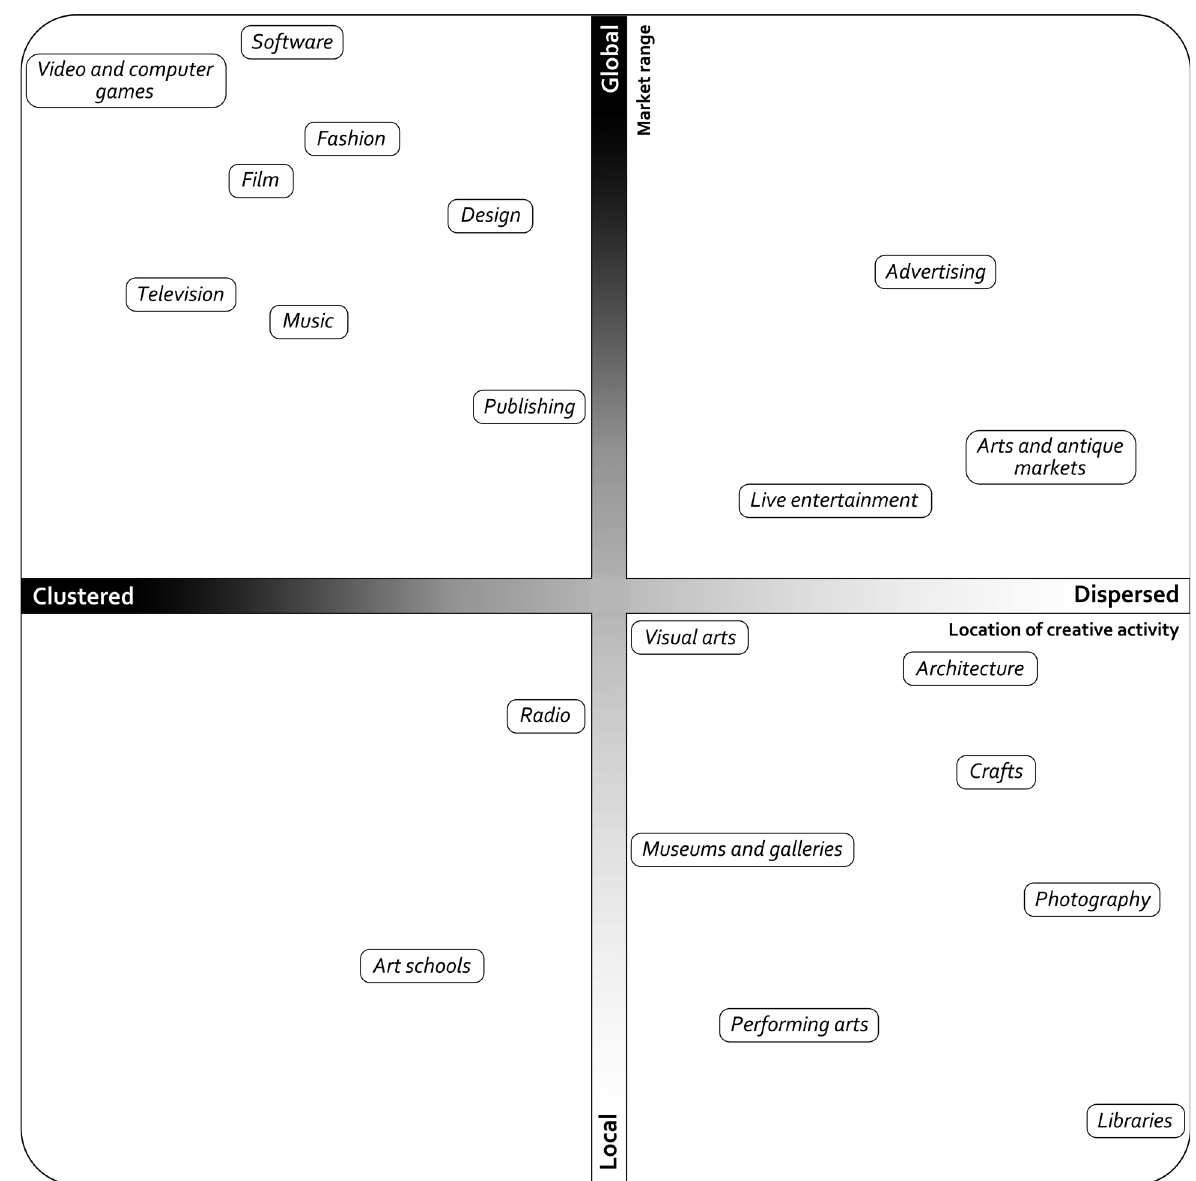
fig. 3. Comparison of cultural and creative industries in terms of two criteria: their location and their market range. Source: own